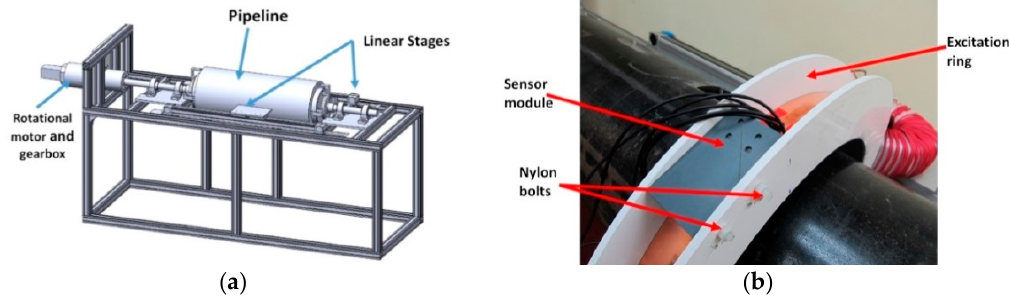
Figure 1. ( a ) Computer-aided design (CAD) drawing of the pipe test rig; ( b ) photograph of the excitation ring and sensor module.